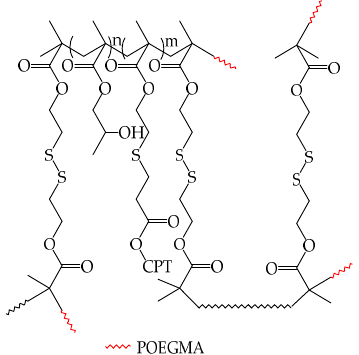
Figure 7. Hyperbranched amphiphilic star copolymers with a HPMA- co -MACPT- co -BS 2 MOE core and a POEGMA (red) hydrophilic shell. Reproduced with permission from reference [34], Royal Society of Chemistry, 2016.